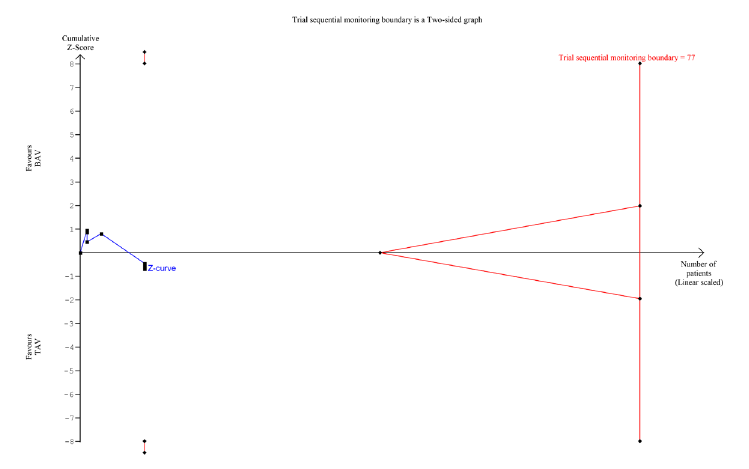
Fig. 10 - Trial sequential analysis diagram for postoperative stroke. BAV=bicuspid aortic valve; TAV=tricuspid aortic